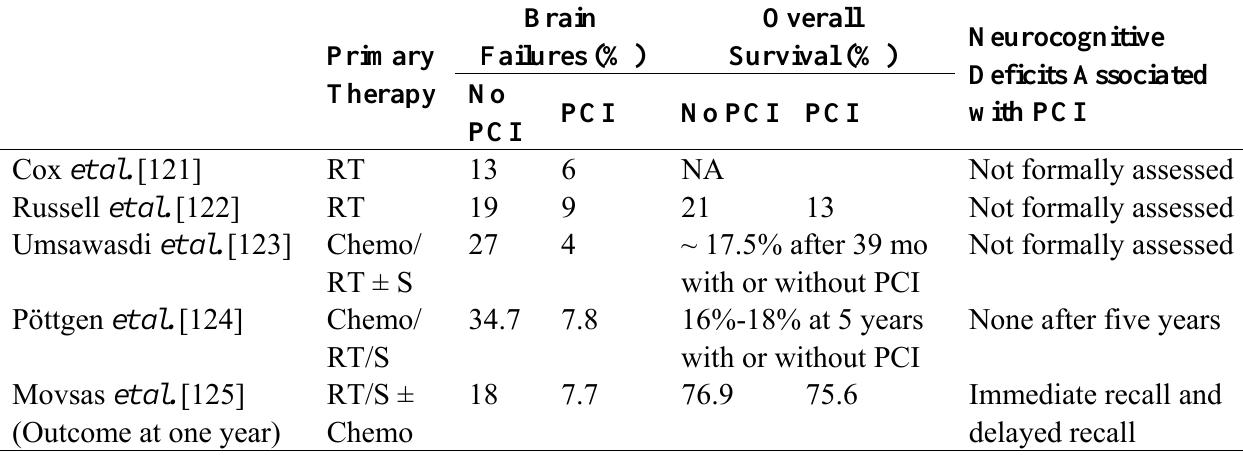
Table 8. Prospective randomized studies evaluating PCI for non-small cell lung